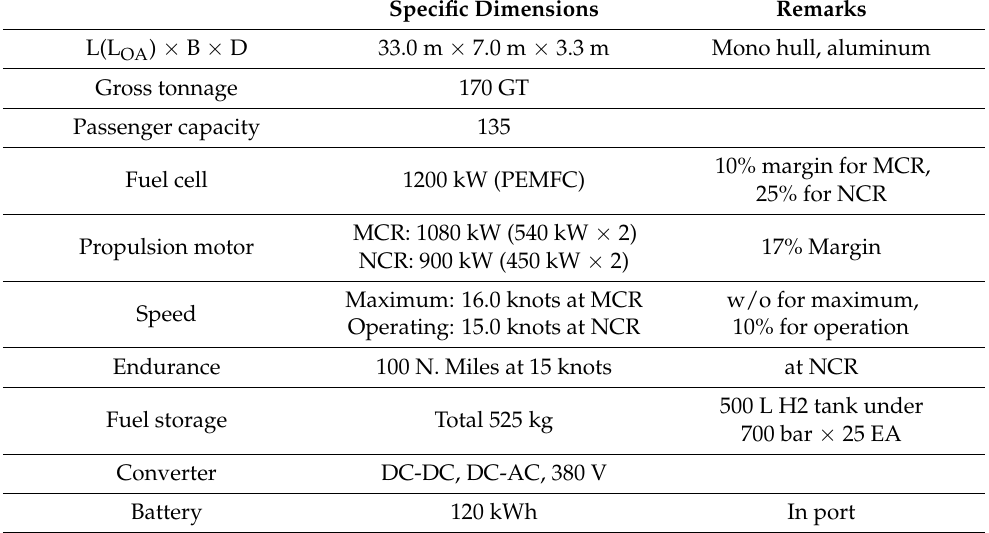
Figure 9. Concept design procedure of nearshore ferry with hydrogen fuel cell propulsion. Table 2. Principal dimensions of the nearshore ferry with hydrogen fuel cell propulsion.